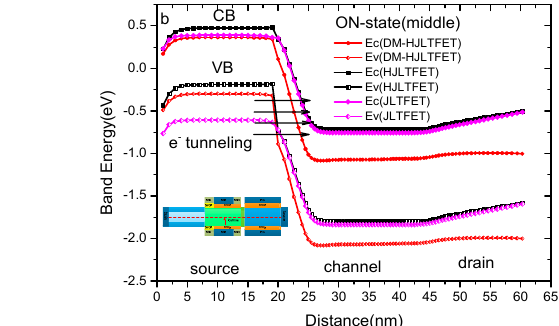
Figure 2. ( a ) Nonlocal band to band tunneling (BTBT) rate of electron; ( b ) nonlocal band to band tunneling (BTBT) rate of hole; ( c ) electric field distribution in DMMG-HJLTFET; ( d ) total current density of DMMG-HJLTFET.